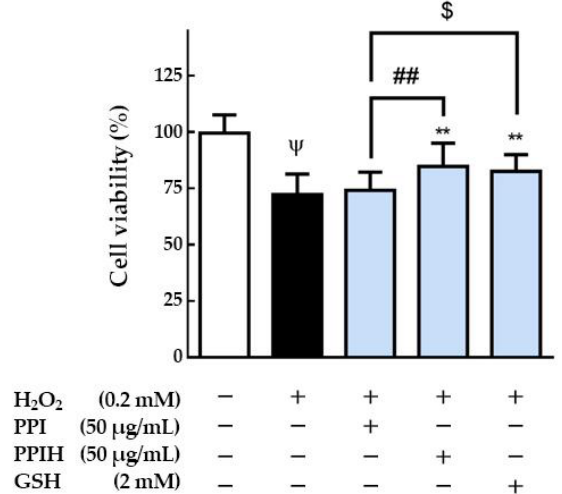
Figure 5. E ff ect of PPI and PPIH on the cell viability of C2C12 cells. C2C12 myoblasts were cultured (1 × 10 4 cells) in 2% horse serum DMEM to di ff erentiate for 6 days. After 6 days of di ff erentiation, cells were pretreated with 50 µ g / mL PPIH for 24 h and then treated with 0.2 mM H 2 O 2 for 1 h. Ψ p < 0.05 versus control (white column), ## p < 0.01 compared with PPI and PPIH, $ p < 0.05 compared with PPI and GSH, ** p < 0.01 compared with the induced group (black column). PPIH: potato protein isolate hydrolysate. GSH: